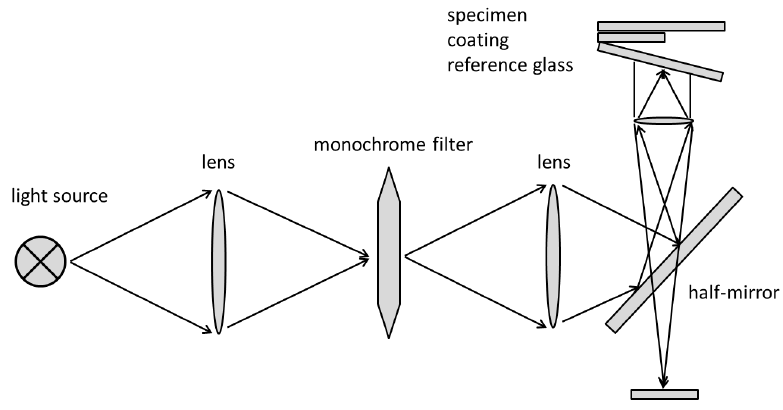
Figure 18. Set up for interference measurement.